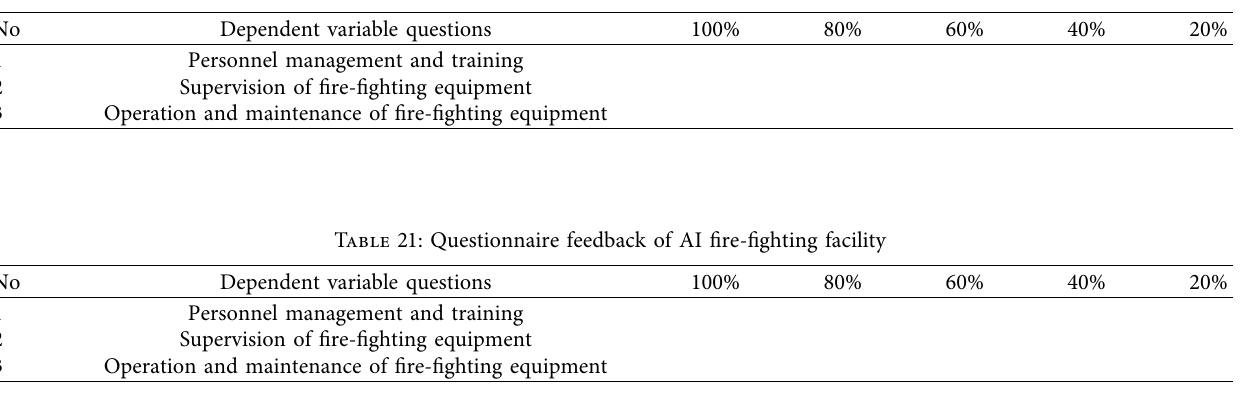
Table 20: Questionnaire feedback of Traditional fre-fghting facility